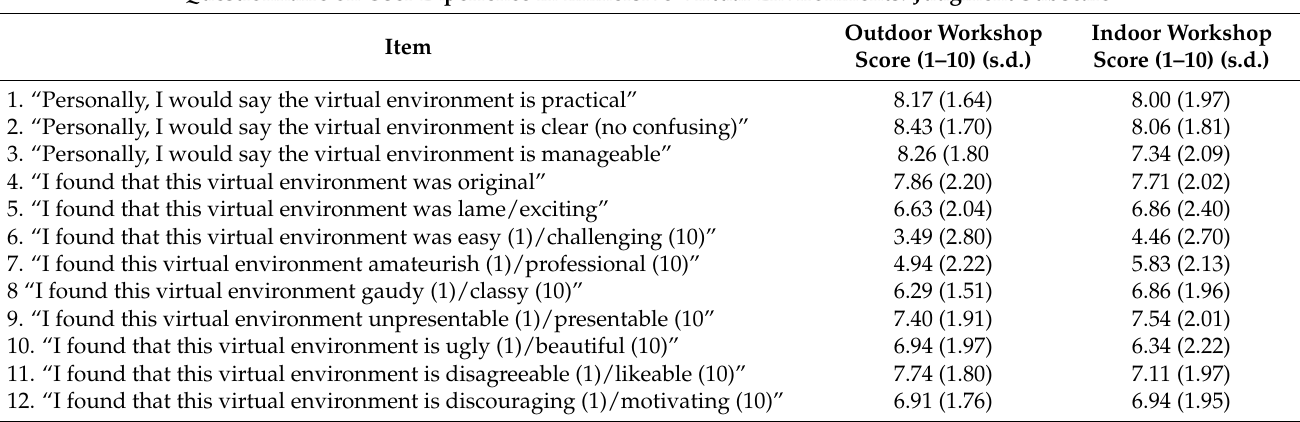
Table 9. Questionnaire on User experience in Immersive Virtual Environments: judgment subscale. Questionnaire on User Experience in Immersive Virtual Environments: Judgment